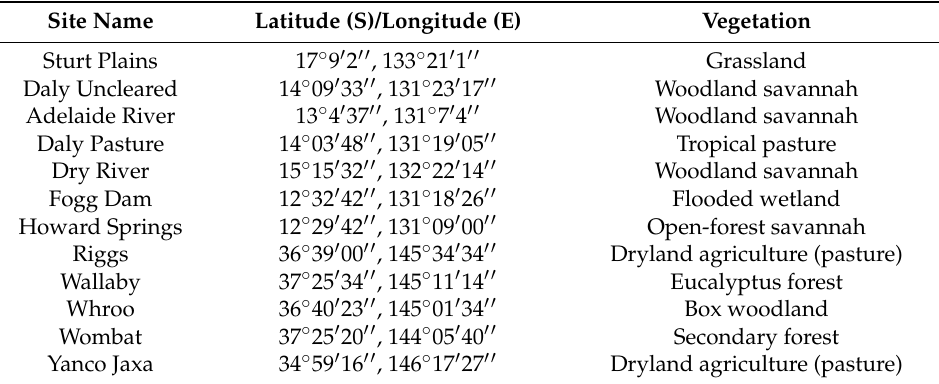
Table 1. Overview of the Australian flux tower sites from the OzFlux network (www.ozflux.org.au) used in this study. The first seven are the northern sites, and the last five are the southern sites.